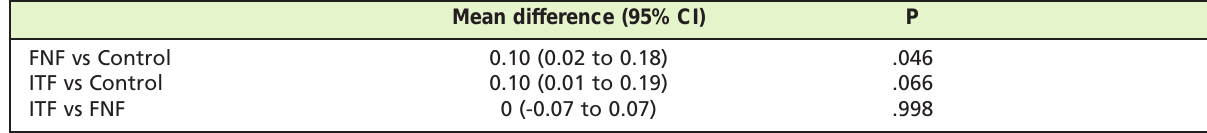
Multiple comparisons test for femoral neck diameter Table III: